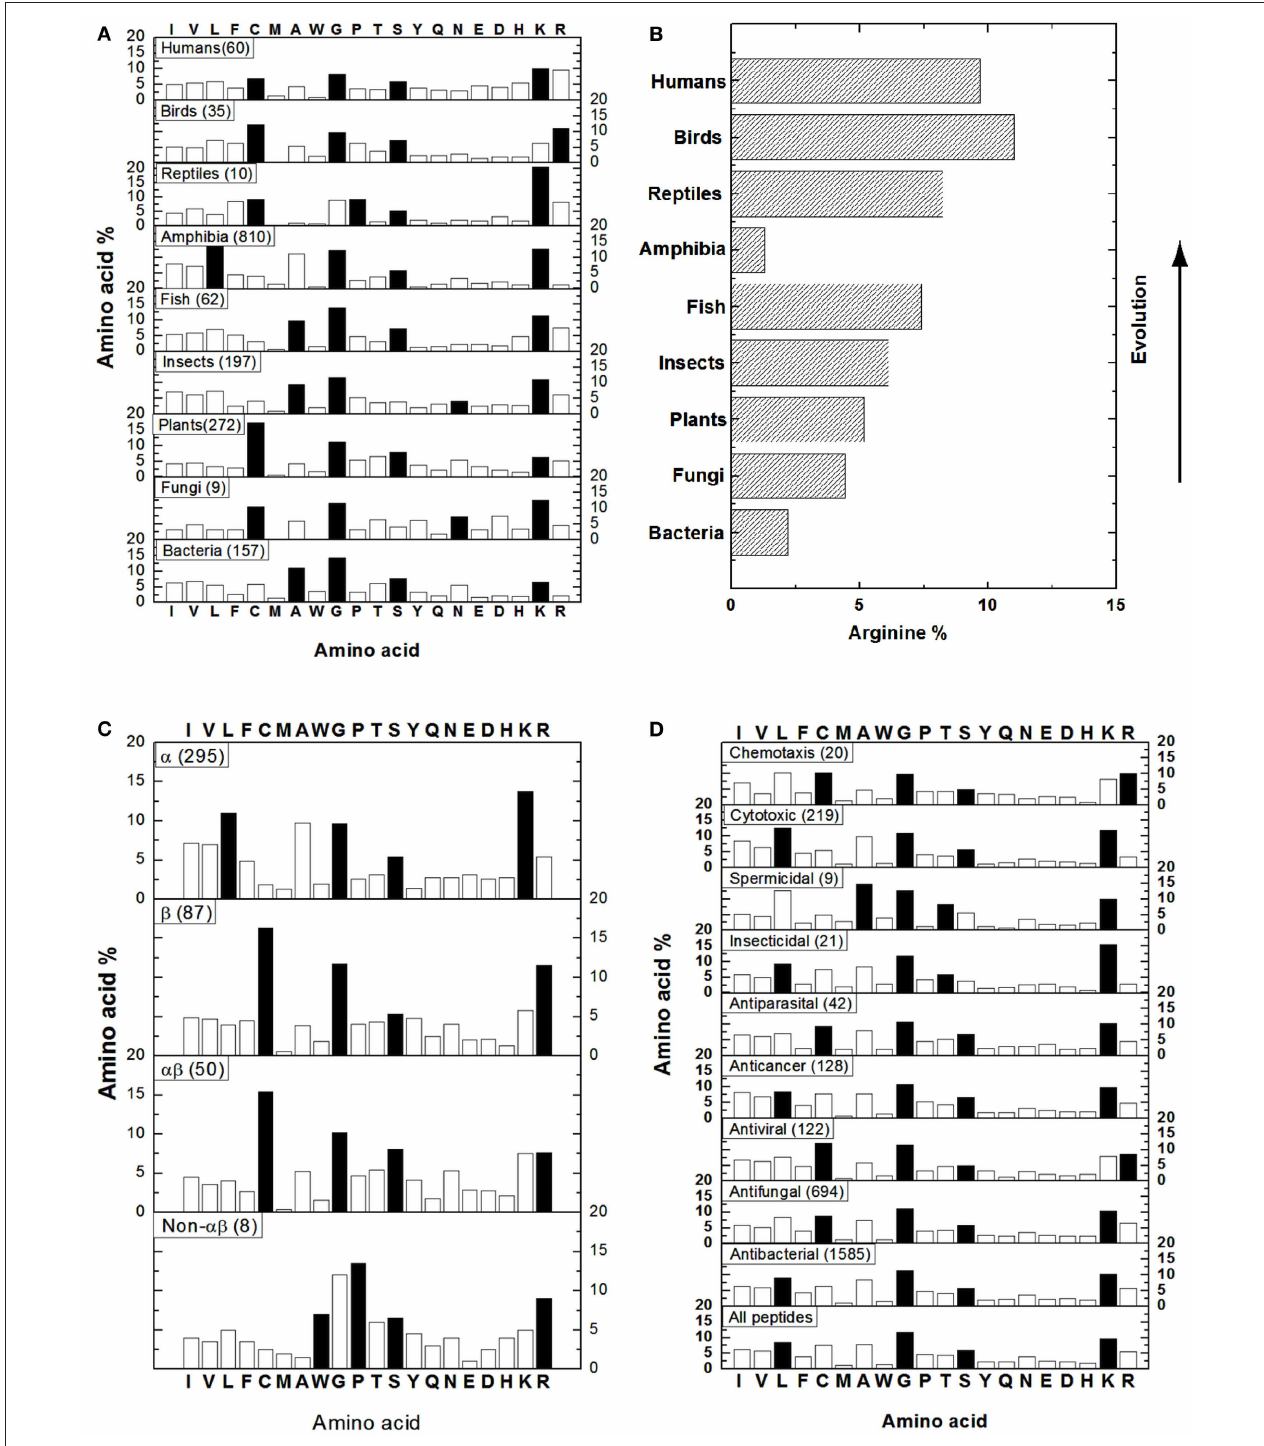
Figure 1 | Amino acid composition analysis of natural AMPs based on source (A,B), structure (C), and activity (D). (B) Shows the arginine percentages of AMPs from different life domains. In each case, the number of peptides included in the bioinformatic analysis is given in parentheses. The solid bars represent the most abundant amino